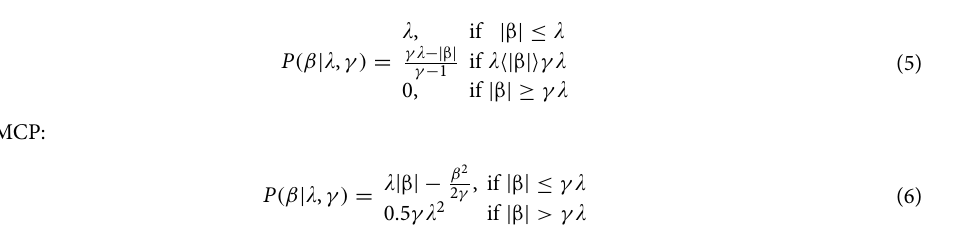
where SSE scad/mcp represents the SCAD or MCP loss function to be minimised, i, y i , ŷ i , j, p and n are as defined in Eq. (3) and